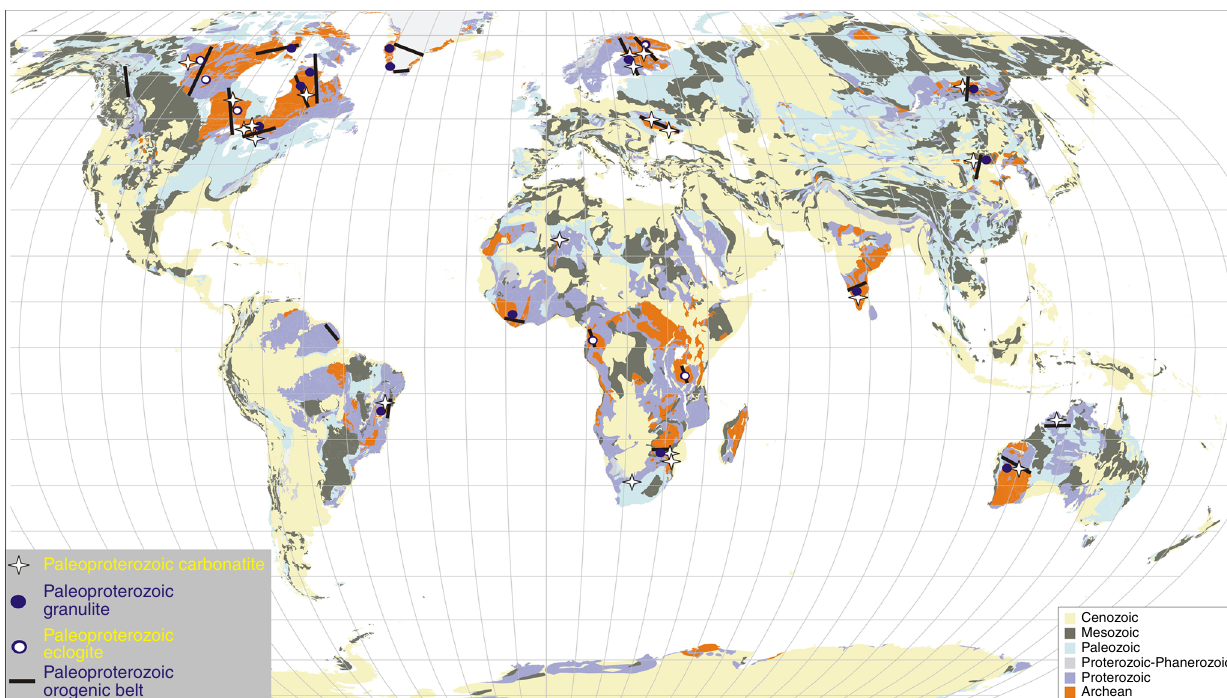
Fig. 5 Distribution of Paleoproterozoic carbonatites, granulites, and eclogites worldwide. The majority of carbonatite occurrences 39 are associated with high-pressure metamorphism (Supplementary Table 12) in Paleoproterozoic orogens